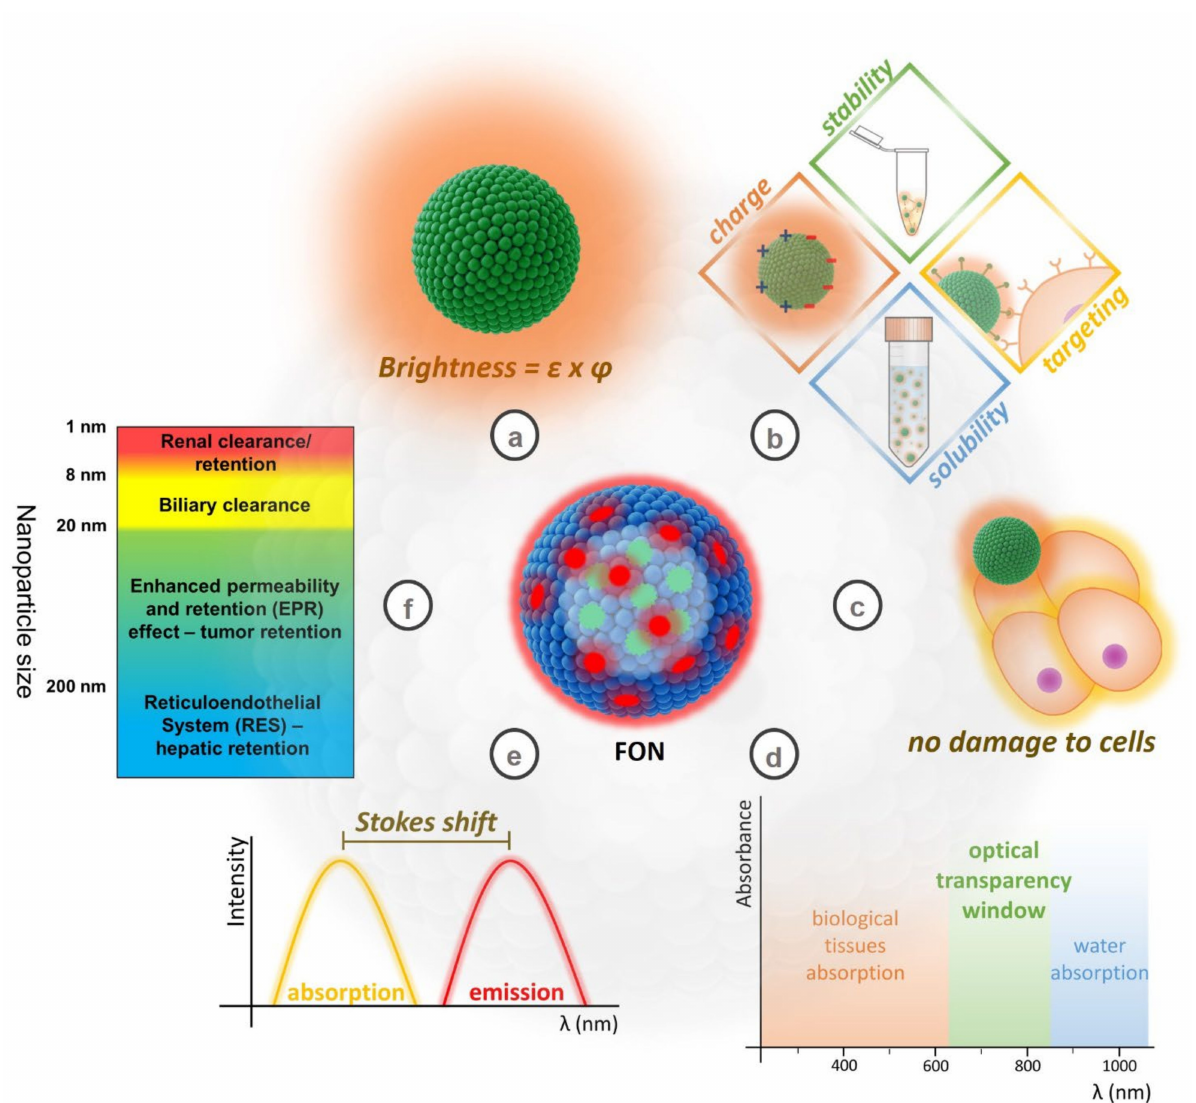
Figure 3. Main features of FONs required for bioimaging application: ( a ) high brightness; ( b ) adequate physicochemical properties; ( c ) low cytotoxicity; ( d ) absorption and emission in the NIR; ( e ) high Stokes shift; ( f ) opportune